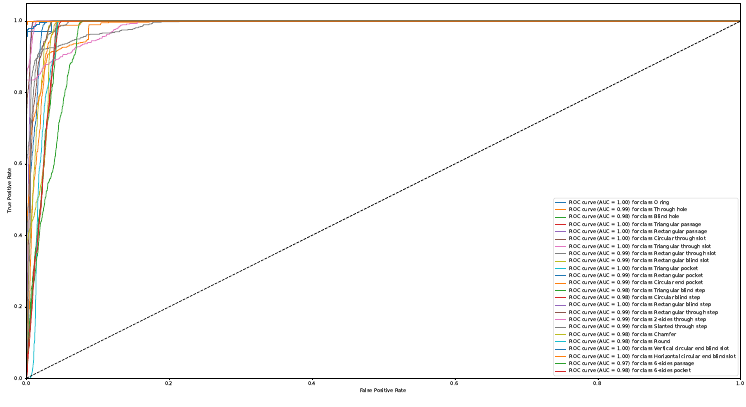
Figure A14. ROC curve for VoxNet